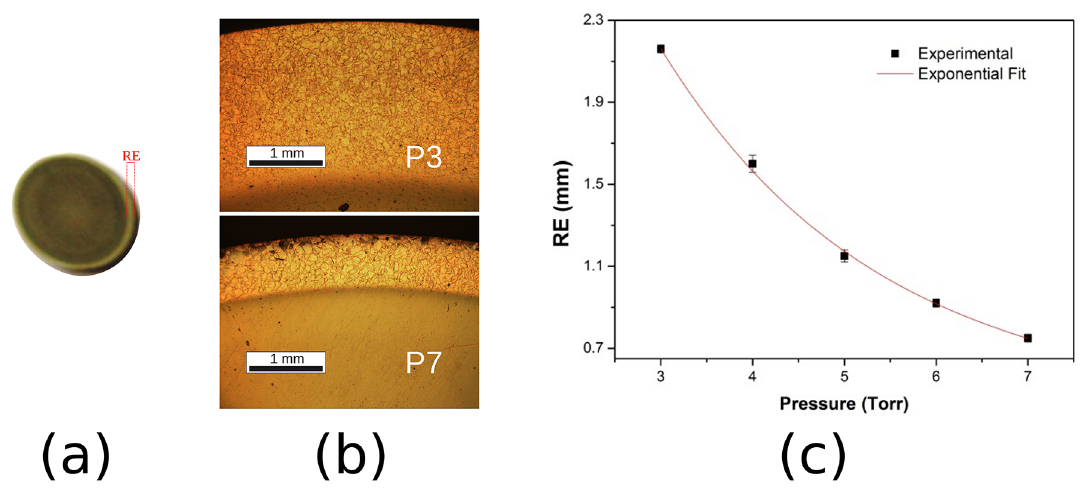
Figure 1. (a) Visual aspect of ring formed on the border of the P6 sample; (b) Optical microscopy image of ring for P3 and P7; (c) Extension of ring as a function of the nitriding pressure.